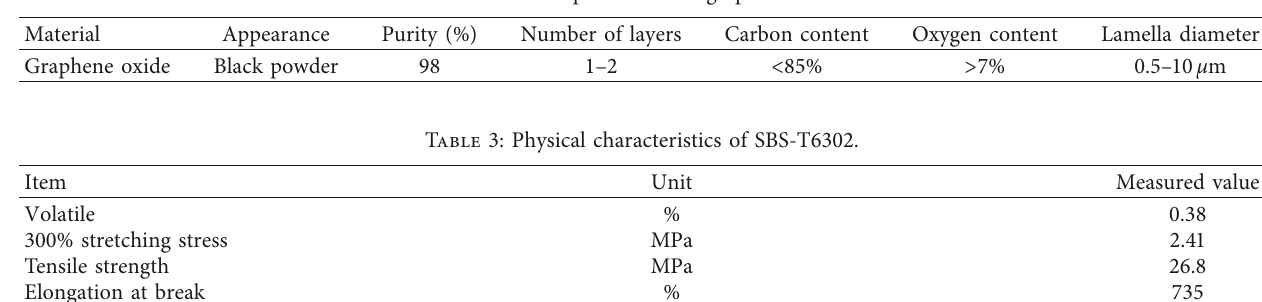
Figure 1: Chemical structure of graphene oxide. Table 2: Basic parameters of graphene oxide.